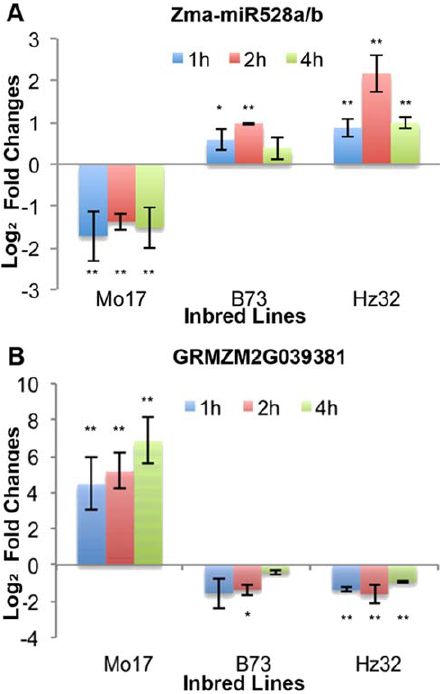
Figure 7. Expression of zma-miR528a/b and one of its targets. A: SLRT-PCR results of miRNA528a/b at 3 biological replicates. B: qRT- PCR results of one of miRNA528a/b targets GRMZM2G039381 at 3 biological replicates. X-axis shows the inbred lines under different time point treatment compared to control. Y-axis shows the expression level. Error bars show the standard deviation. Student t test was performed on qRT-PCR results. ** denotes the p value , 0.01 and * denotes the p value ,